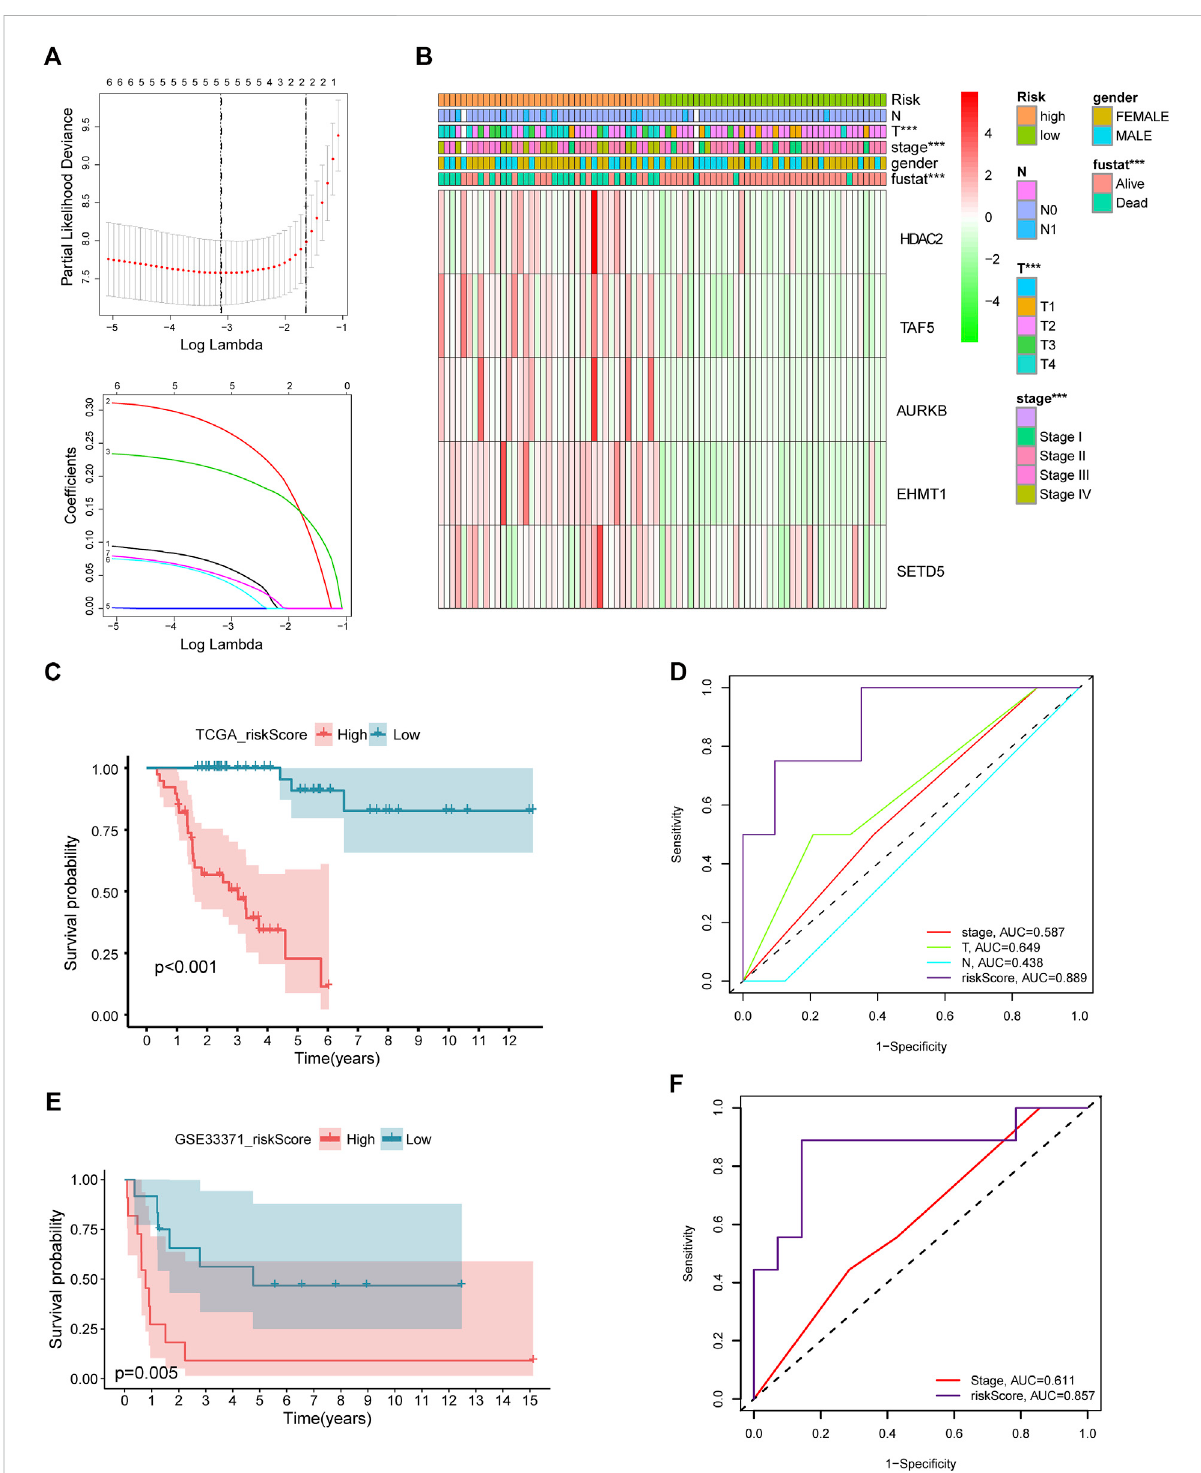
FIGURE 2 Lasso Cox regression of DECRs (A) . Expression of fi ve selected DECRs in different clinical features groups (B) . KM survival analysis of low- and high-riskpatientsintestcohort (C) .ROCanalysisofclinicalstage,clinicalTstage,clinicalNstageandriskscoreintestcohort (D) .KMsurvivalanalysis of low- and high-risk patients in validation cohort (E) . ROC analysis of stage and riskscore in validation cohort (F)